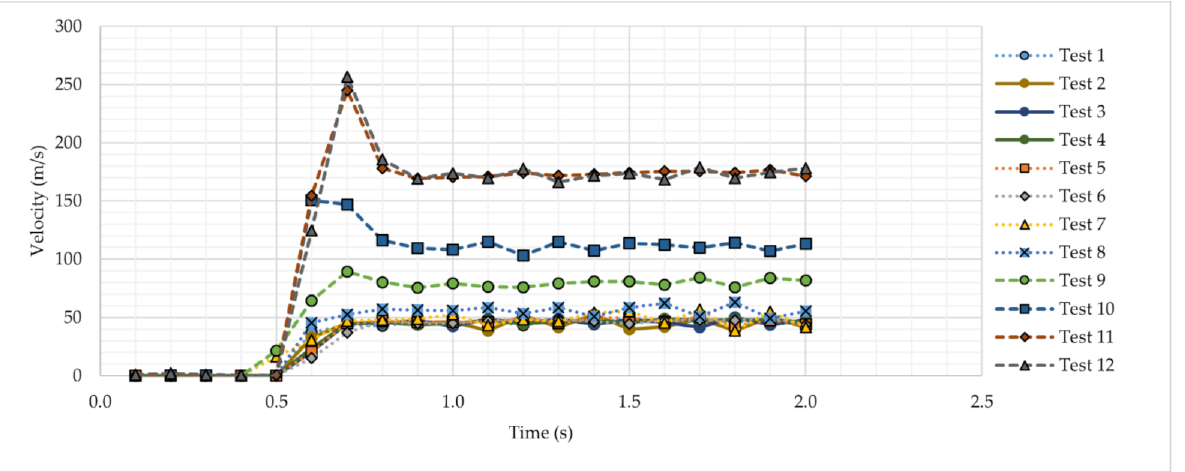
Figure 9. Calculated velocity through valve constriction using conservation of mass, uncorrected for valve lift extension.